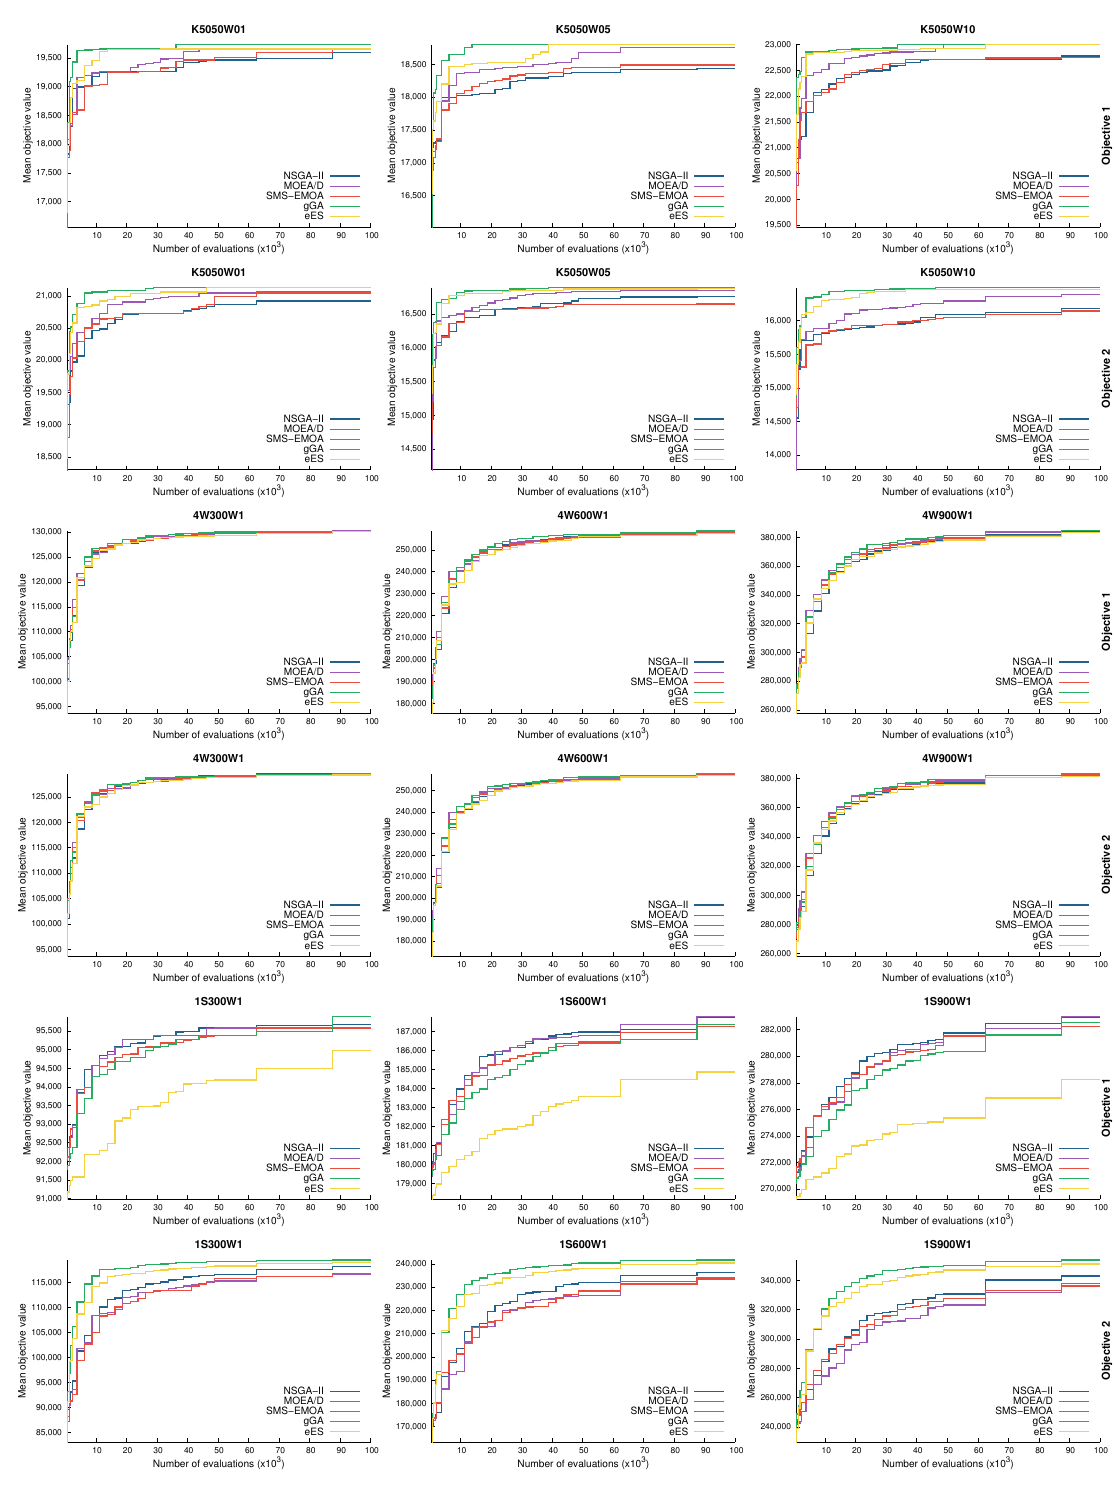
Figure 2. KNP evolution of the mean fitness for objectives 1 and